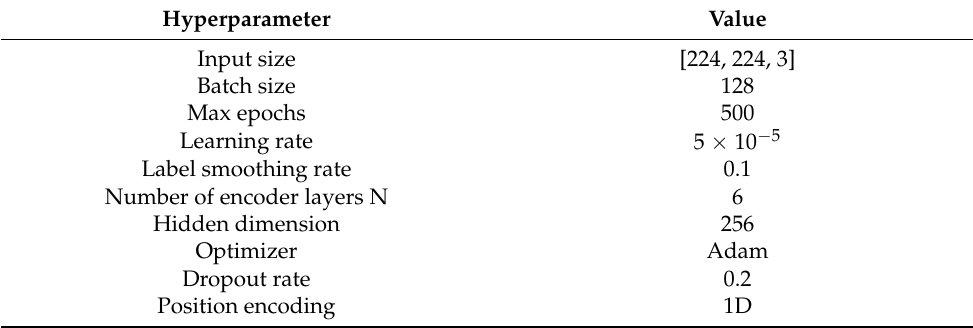
Table 1. The optimization structure and hyperparameters for the proposed Sl transformer.